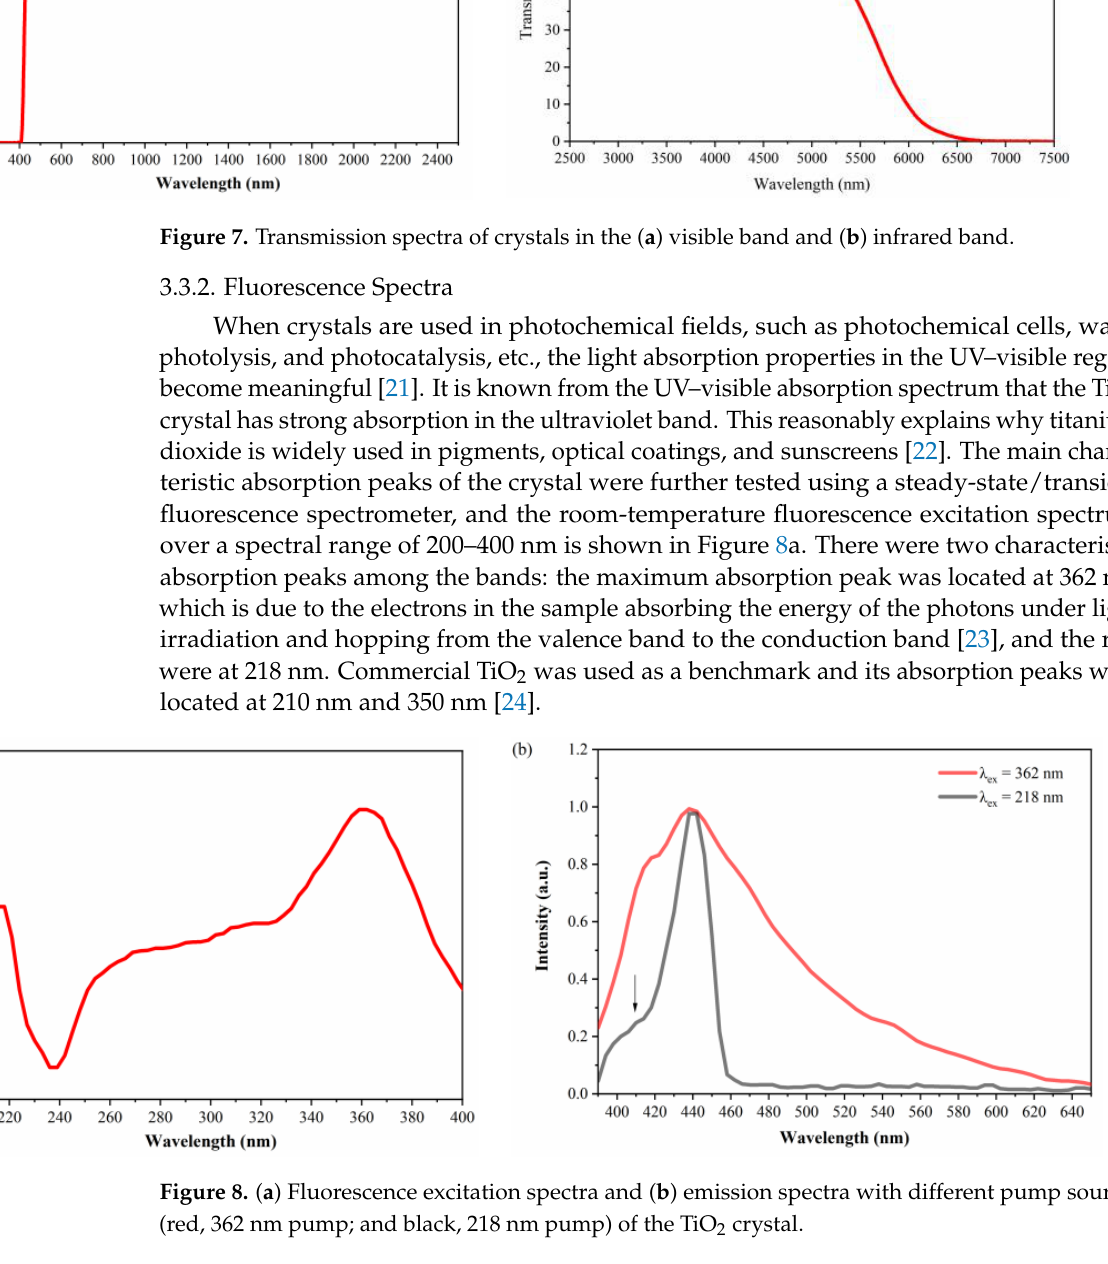
Figure 7. Transmission spectra of crystals in the ( a ) visible band and ( b ) infrared band.